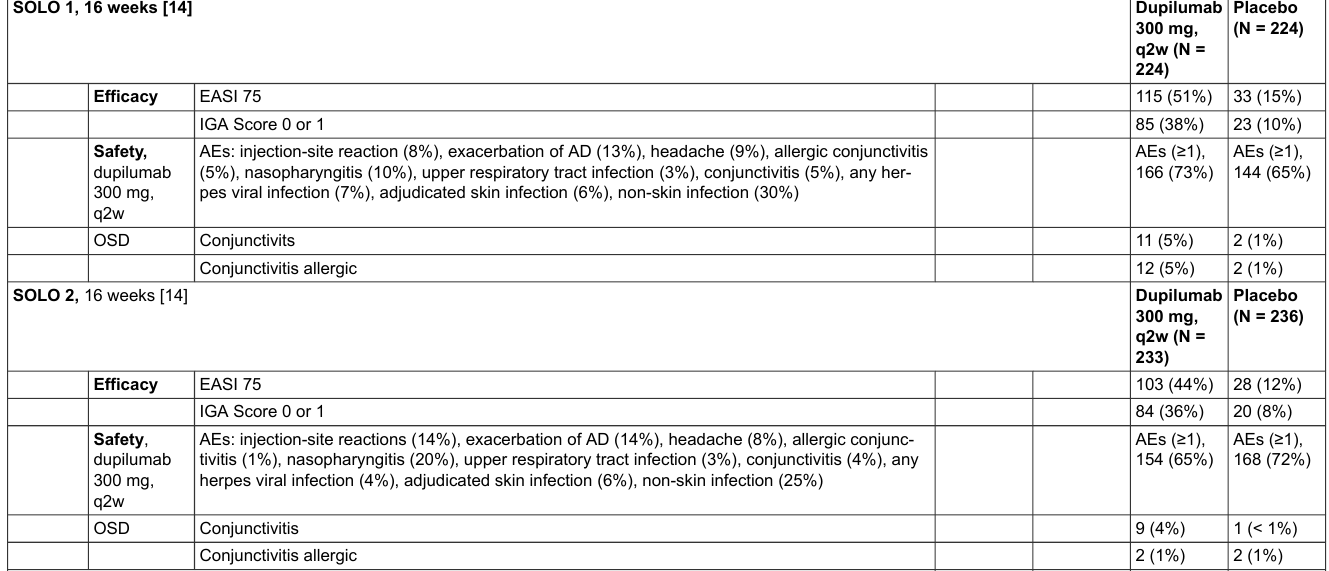
Table S1: Efficacy and safety of dupilumab in phase III clinical trials [14–19]. (Disclaimer: The only approved dosing regimen of dupilumab for the treatment of moderate-to-severe atopic dermatitis is every 2 weeks.) SOLO 1, 16 weeks [14] Dupilumab Efficacy EASI 75 115 (51%) 33 (15%) IGA Score 0 or 1 Safety, dupilumab 300 mg,